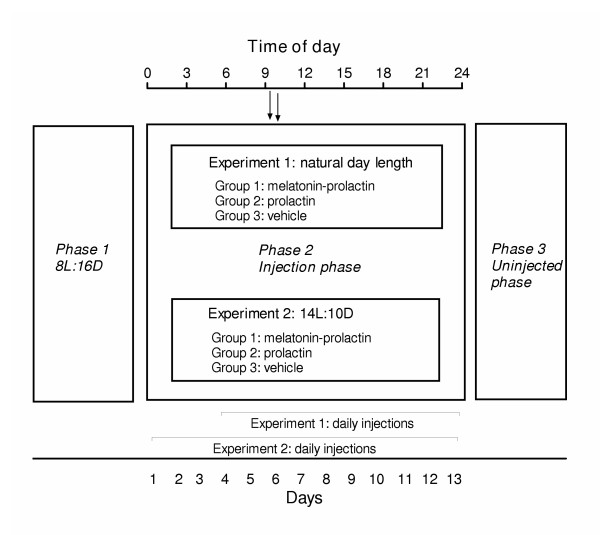
Experimental design. Both experiments had three phases: phase 1- pretreatment with 8 hours light: 16 hours darkness (8L:16D); phase 2- injection phase under natural day length (experiment 1) or 14L:10D; phase 3- uninjected phase. Arrows on top indicate time of injections (left: zeitgeber time (ZT) 9.5 – melatonin; right: ZT 10 – prolactin or vehicle; ZT 0 = the time of sunrise for the experiment 1, the time of onset of light for the experiment 2). Lines at the base of phase 2 indicate number of days of injection. The experiment 1 was terminated after 23 days and the experiment 2 was terminated after 22 days from the beginning of the phase 2.